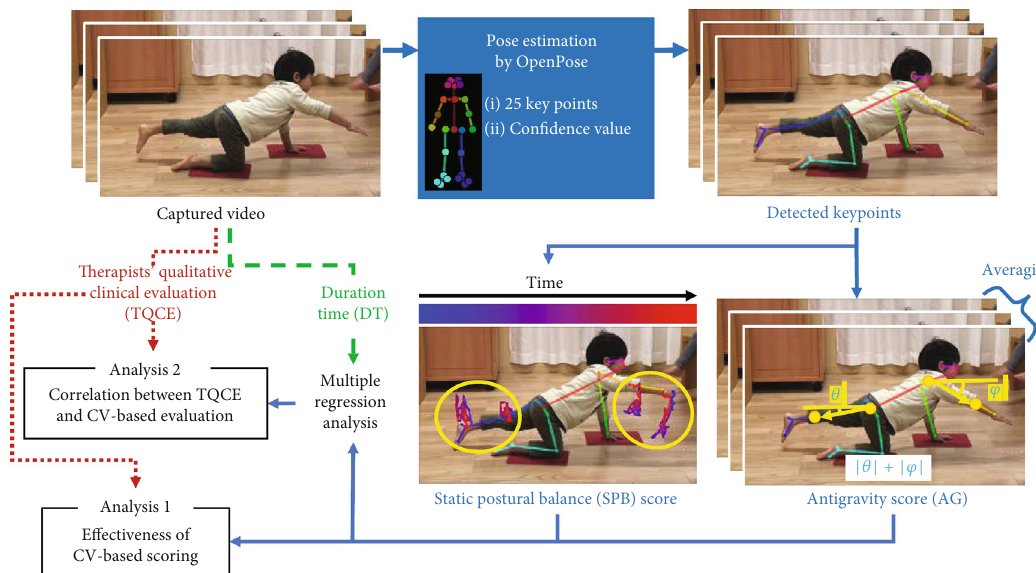
Figure 1: Research fl